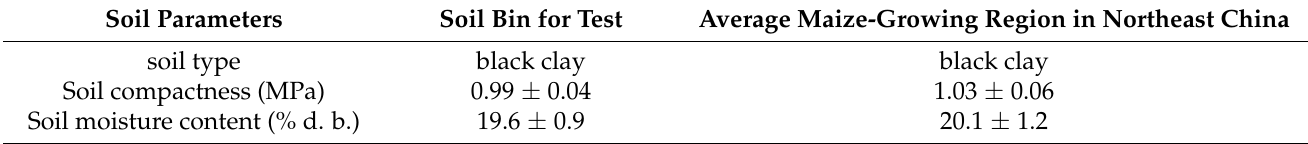
Table 2. Indicators of the soil in the soil bin before the test.